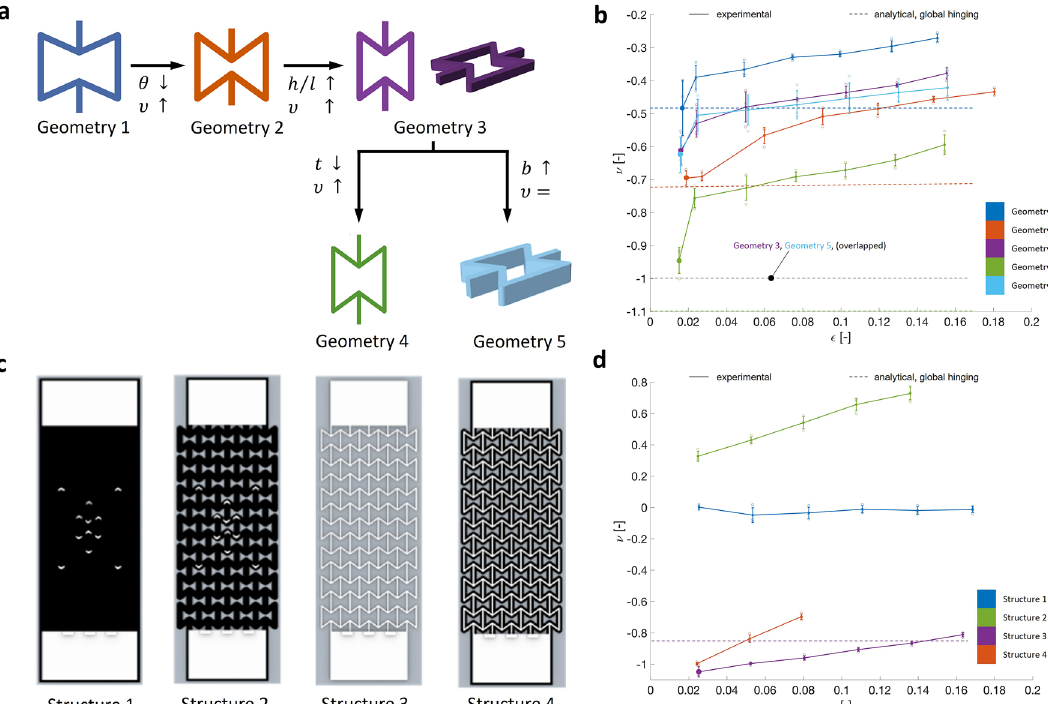
Figure 5. Experimental results ( a ) The five different geometries of reentrant honeycombs investigated. ( b ) Experimental results of the Poisson’s ratio ν over the engineering strain ε for the five geometries. In this chart also the Poisson’s value obtained from the analytical equations (global hinging) are mapped as lines (they do not depend on the engineering strain) ( c ) The four structures tested to measure the Poisson’s ratio, involving Structure 1 as a standard KT, Structure 2 realized as standard KT with auxetic perforations, Structure 3 as a 3D-printed auxetic structure, and Structure 4 as a combination of Structures 2 and 3 glued to each other. Structures 1 and 2 include v -shaped marks as relevant points for measuring the Poisson’s ratio ( d ) Results of the Poisson’s ratio ν over the engineering strain ε for the four analyzed structures. In this chart, for Structure 3, also the Poisson’s value obtained from the analytical equations (global hinging) is mapped as a